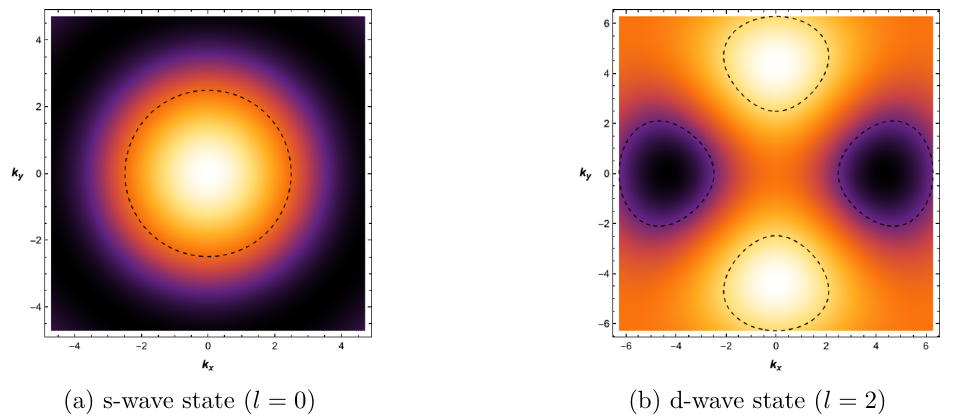
Figure 3. Density plot of l -wave states in momentum space. α 01 = 0 , α 21 = 5 . 1356 for l = 0 , 2 respectively.